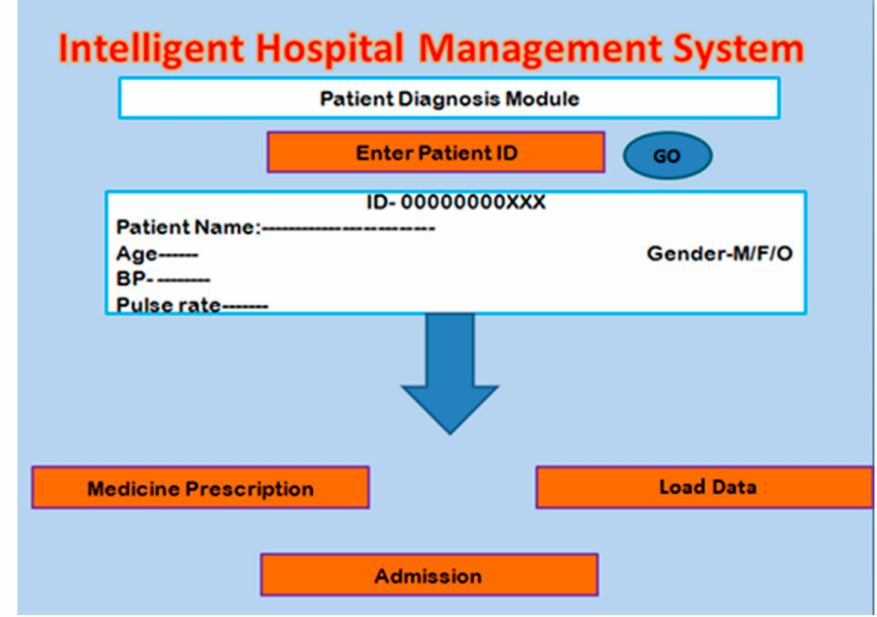
Figure 3. Patient Diagnosis Module.